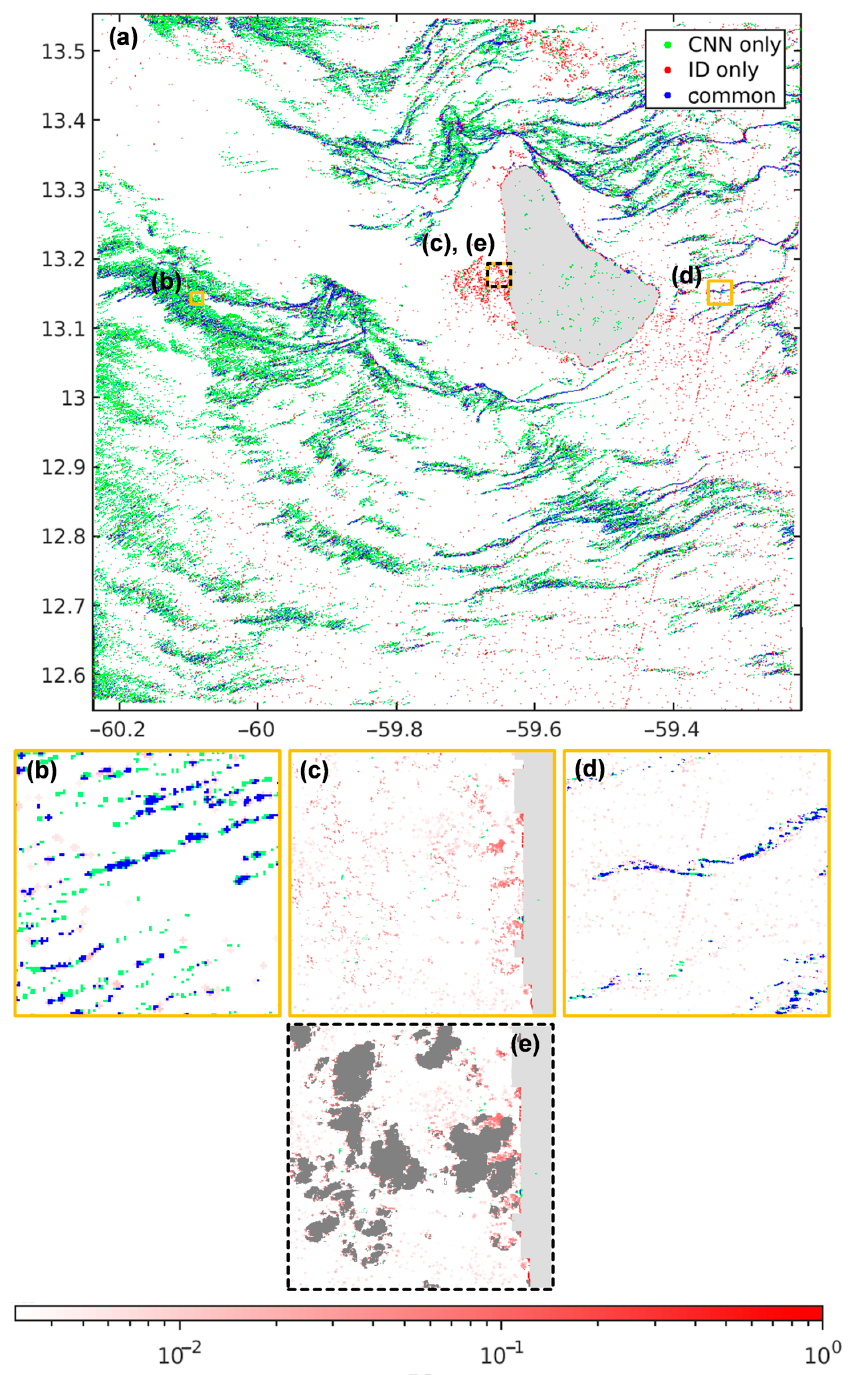
Figure 6. ( a ) Sargassum detections from MSI with the CNN and ID methods: detected by both methods (blue), detected by the CNN but not by the ID method (green) and detected by the ID method but not the CNN (red). Only FCs above 1.16 × 10 − 2 are represented in ( a ), in order to clarify the figure. Below this threshold the image is too contaminated by a large number of isolated pixels without spatial consistency (discussed in Section 4.2), which start to be visible below this threshold; and ( b – e ) sub-images from ( a ) with a color scale for all IDs. FC, cloud (dark gray) and land masks (light gray) come from Descloitres et al. [22]. MSI image, PRV tile from 29 January 2019.